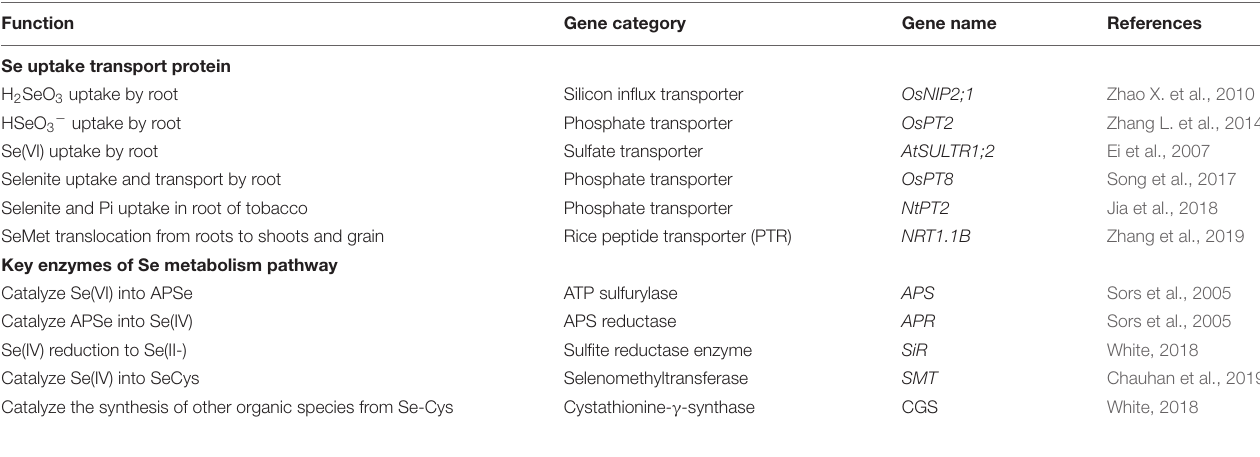
TABLE 1 | The main genes involved in Se uptake, transport, and metabolism in